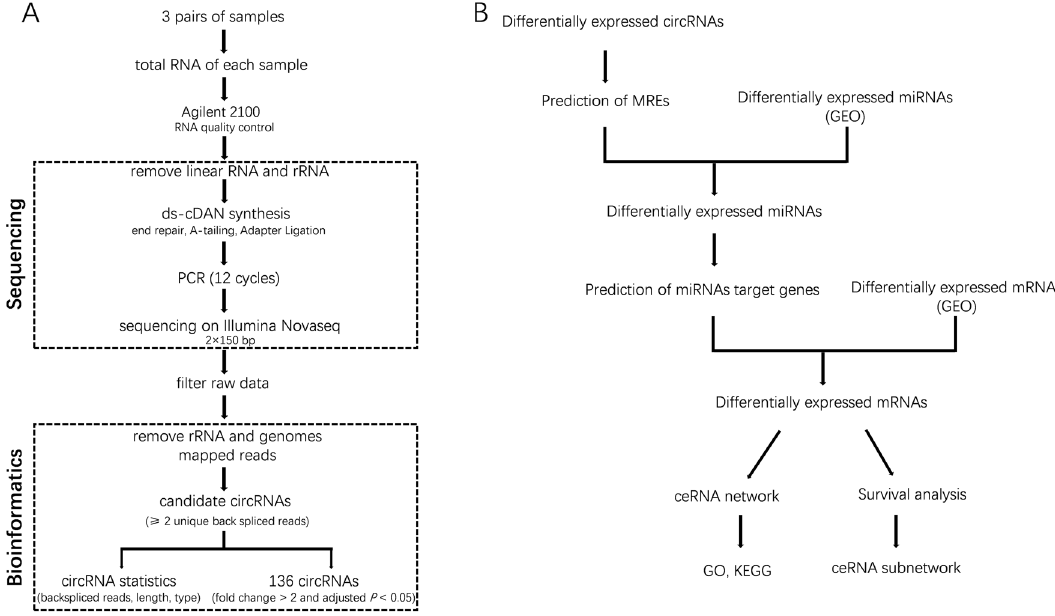
Figure 1. ( A ) CircRNA sequencing library construction method, sequencing protocol and flow chart of bioinformatics analysis. ( B ) Flow chart of ceRNA network